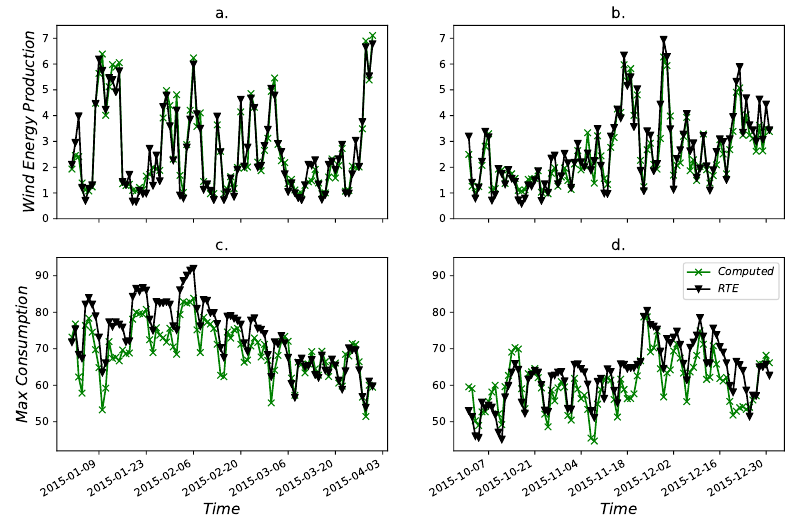
Figure 4. French daily wind energy production ( a ) in winter and ( b ) in fall 2015 from RTE data (in black) and computed using ERA-I surface wind speed (in green) ; and French daily maximum consumption ( c ) in winter and ( d ) in fall 2015 from RTE data (in black) and computed using ERA-I surface temperature (in